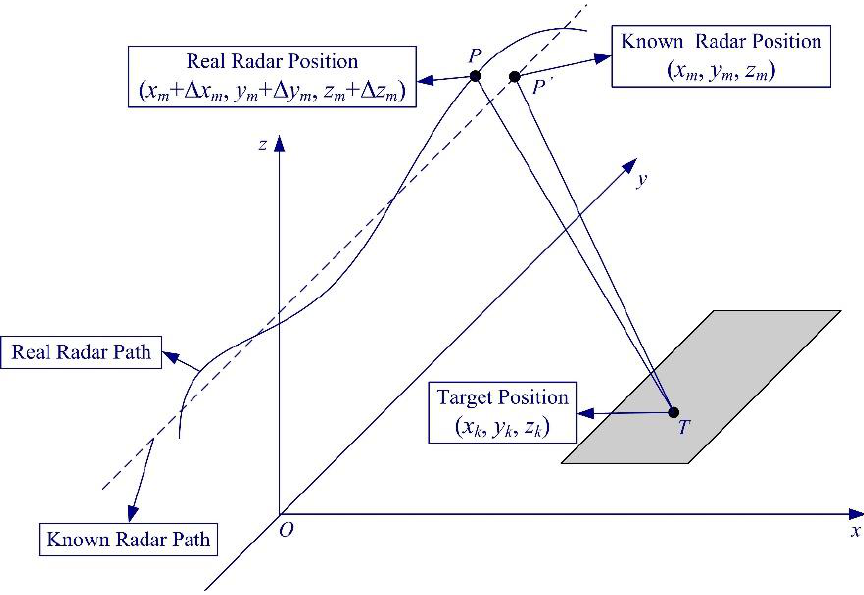
Figure 15. Geometry of the observation position errors in SAR. (Taken from [84]).